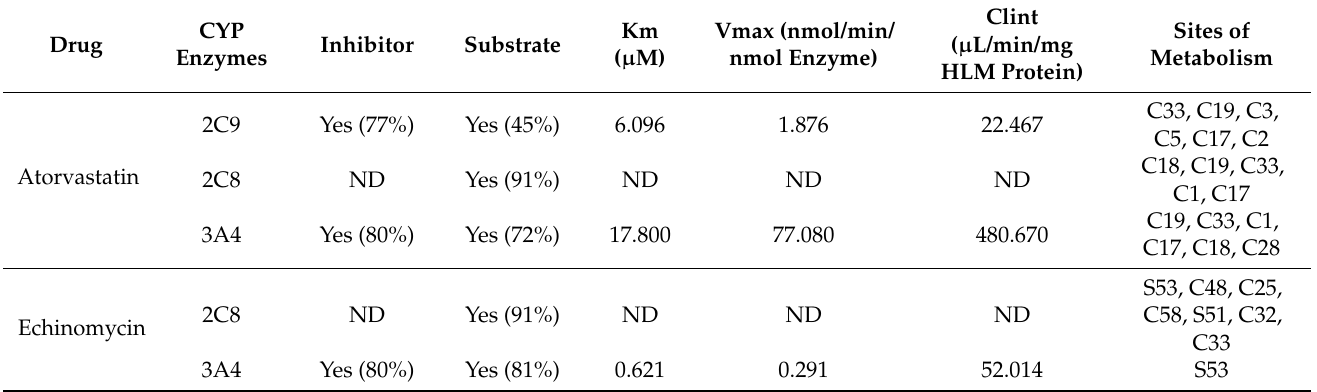
Table 2. Metabolism values of atorvastatin and Echinomycin by CYP enzymes, estimated in the ADMET Predictor. ND, not